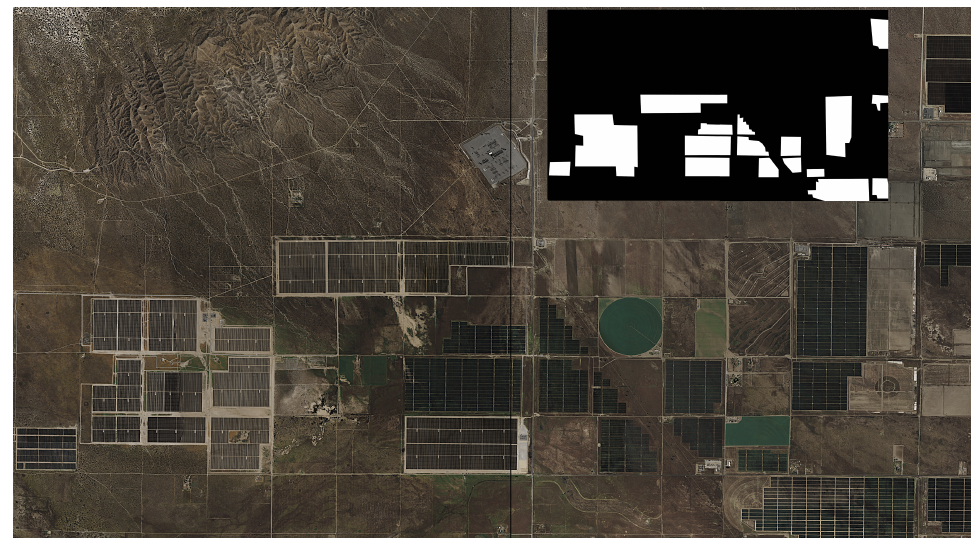
Figure A3. Solar Star (34 ◦ 49 (cid:48) 50 (cid:48)(cid:48) N, 118 ◦ 23 (cid:48) 53 (cid:48)(cid:48) W), the world’s largest solar farm, along with its corresponding hand-labeled annotation.